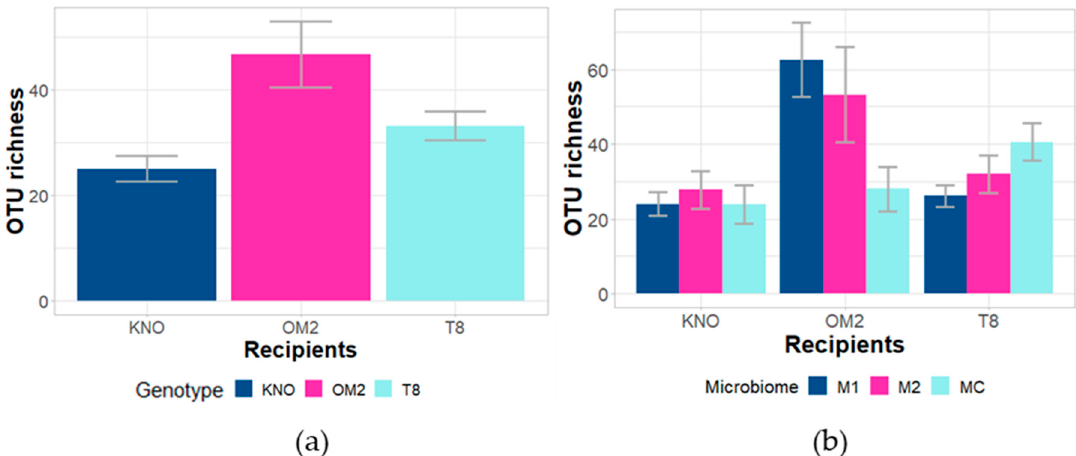
Figure 6. Effect of ( a ) genotype and ( b ) genotype × microbiome interaction for recipient samples on OTU richness. Error bars indicate standard error.